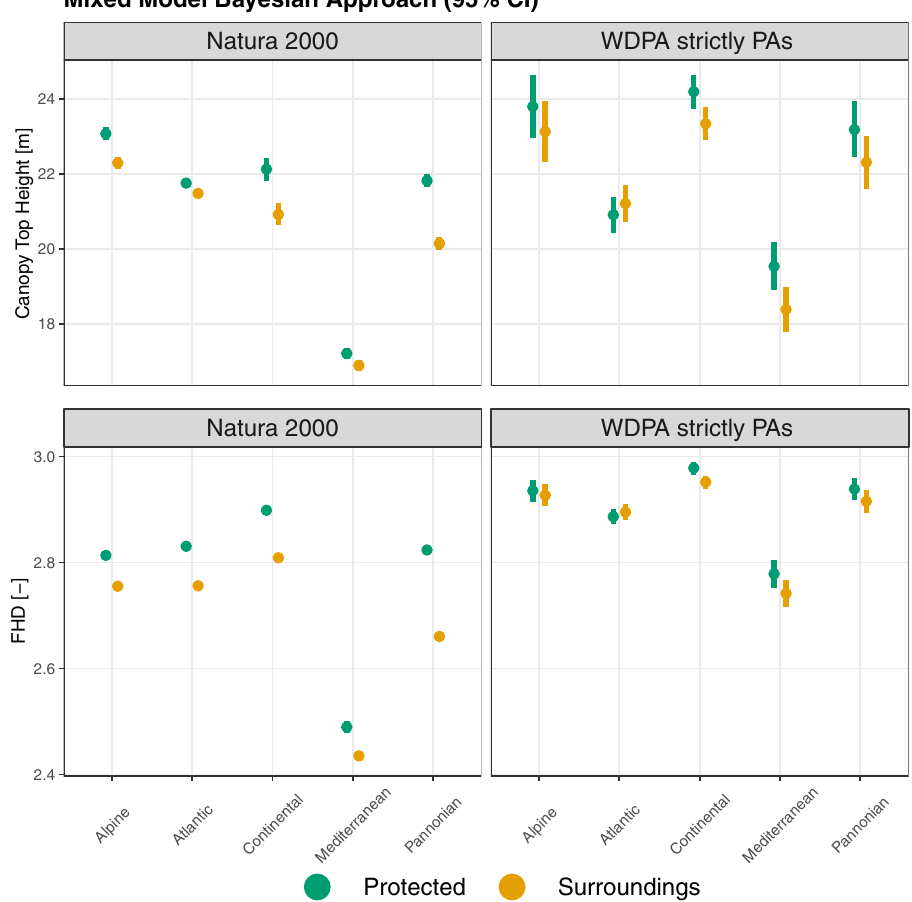
Fig. 4 Generalized Linear Mixed Model analysis of differences in vertical structural attributes. Results of the generalized linear mixed model showing the Canopy Top Height and Foliage Height Diversity for Protected Areas and Unprotected Surroundings in Natura 2000 and in the strictly protected sites according to the World Database on Protected Areas (WDPA) for different biogeographical